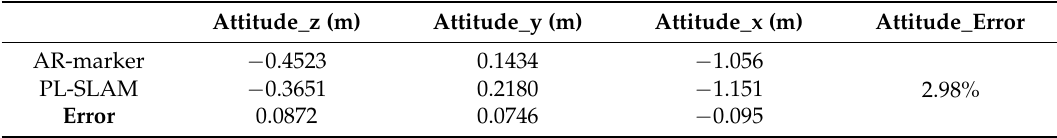
Figure 10. Camera vision in the experiment described in Section 3.1. ( a ) Camera vision at the beginning; ( b ) Camera vision at the end. Table 1. Error comparison of termination